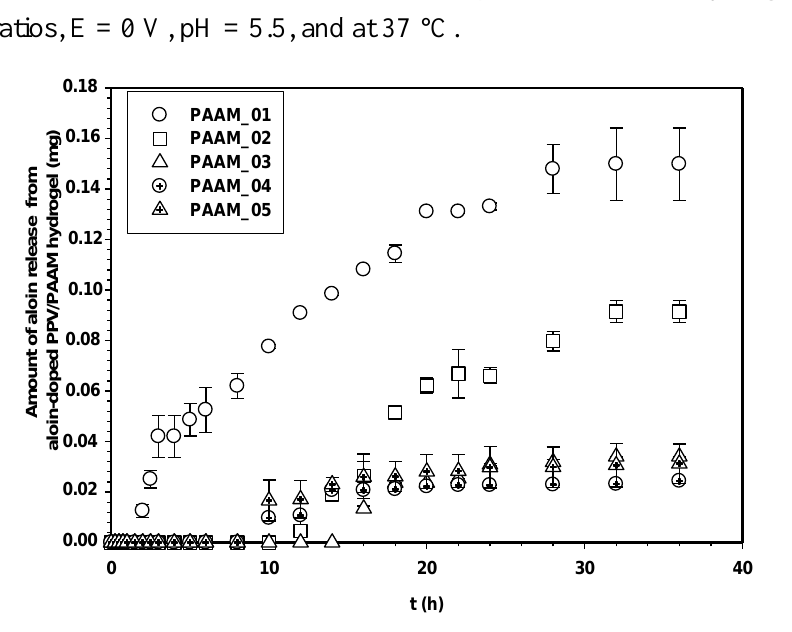
Figure 8. Amounts of aloin released from aloin-doped PPV/PAAM (PAAM_03) hydrogel at various crosslinking ratios, E = 0 V, pH 5.5, and at 37